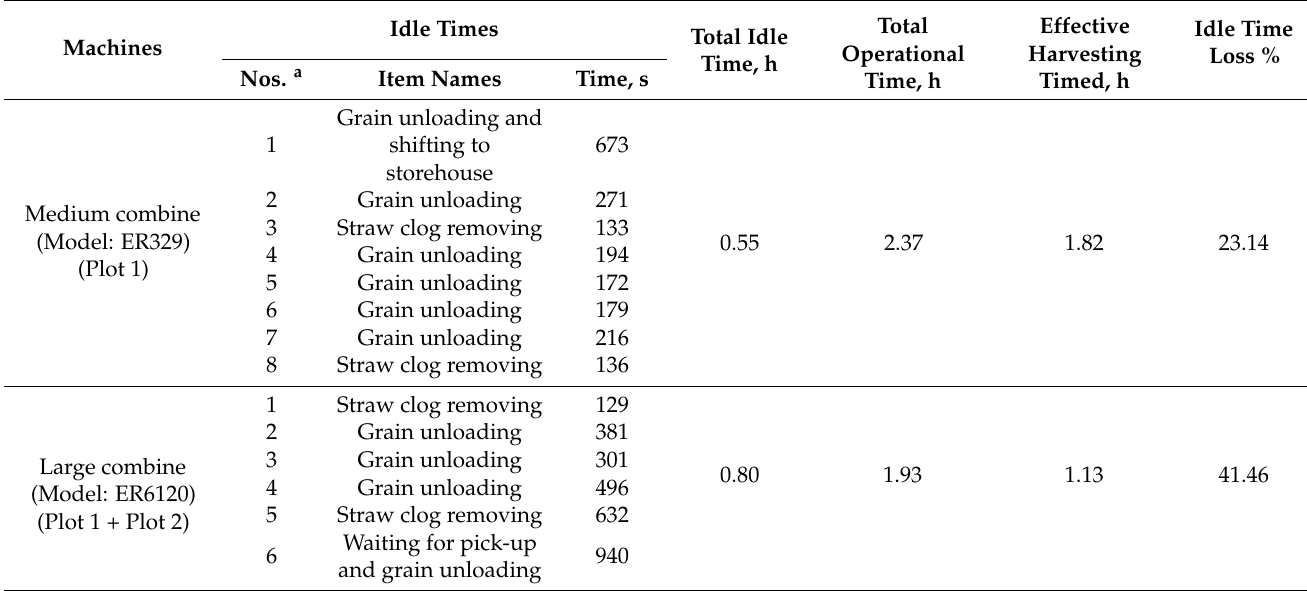
Table 3. Idle time loss of the combine